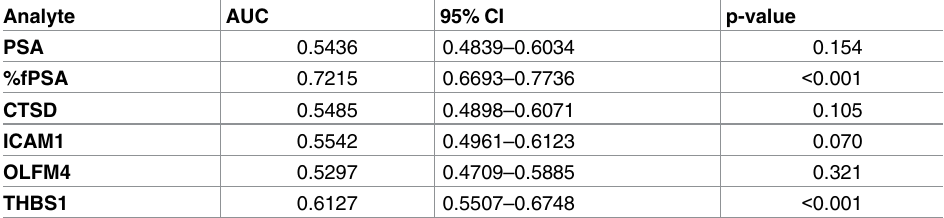
Table 3. Receiveroperating characteristics (ROC) of the individual